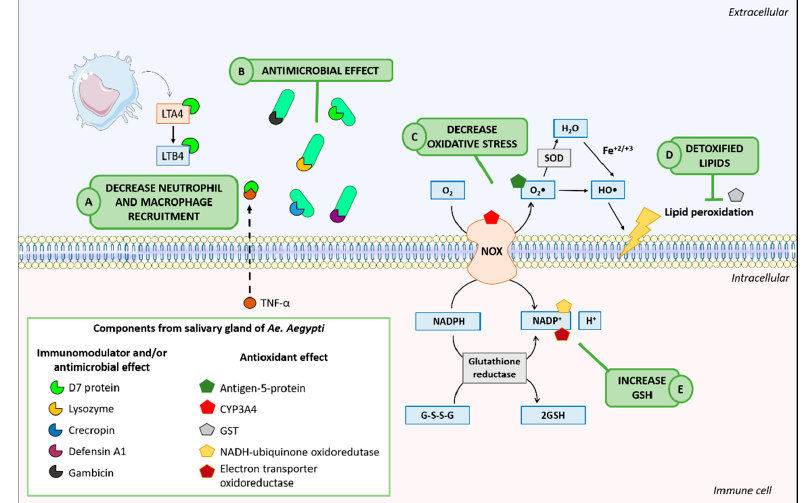
Figure 8. Probable mechanism of action of Ae. aegypti’s SGE in CLP sepsis model. (A) The D7 protein of SGE binds to LTB4 and reduces TNF- α production, decreasing neutrophil and macrophage recruitment to the inflammatory site. (B) The SGE has lysozyme, crecropin, D7 protein, defensin A1, and gambicin, which interact with bacterial surfaces and result their elimination. (C) By a different mechanism, SGE modulates oxidative stress, and SOD converts the superoxide into oxygen or hydrogen peroxide, which are less reactive molecules. (D) SGE reduce lipid peroxidation by restoring antioxidant system. (E) NADH restores the reduced GSH to its active form, increasing GSH bioavailability and reducing lipid peroxidation. CLP: cecal ligation and puncture; SGE: salivary gland extract; LTB4: Leukotriene B4; TNF- α : tumor necrosis factor - alfa; SOD: superoxide dismutase; GSH: